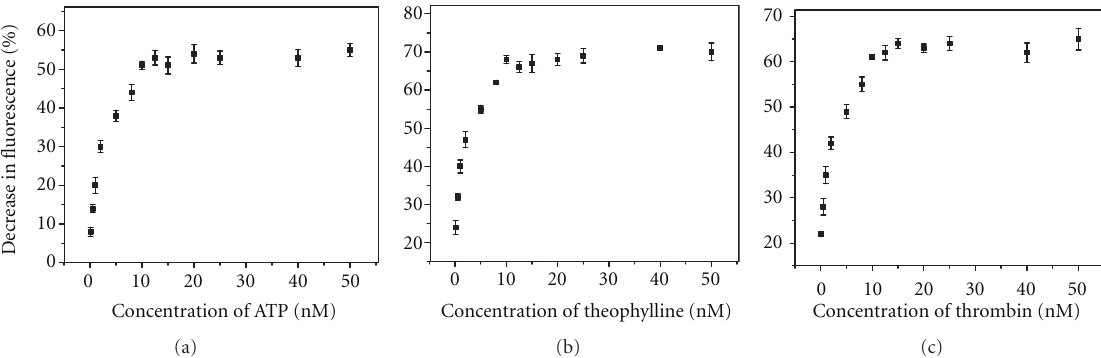
Figure 6: Fluorescence signaling by chromophores in presence of aptamers exposed to variable amounts of cognate target. Chromophores used for (a) ATP, (b) theophylline, and (c) thrombin were, respectively, Hoechst 33258, TO, and SYBR Green I. The % decrease in fluorescence is calculated from the di ff erence in fluorescence intensities of 25 nM chromophores in presence of 10 nM aptamer and variable amounts of cognate target.